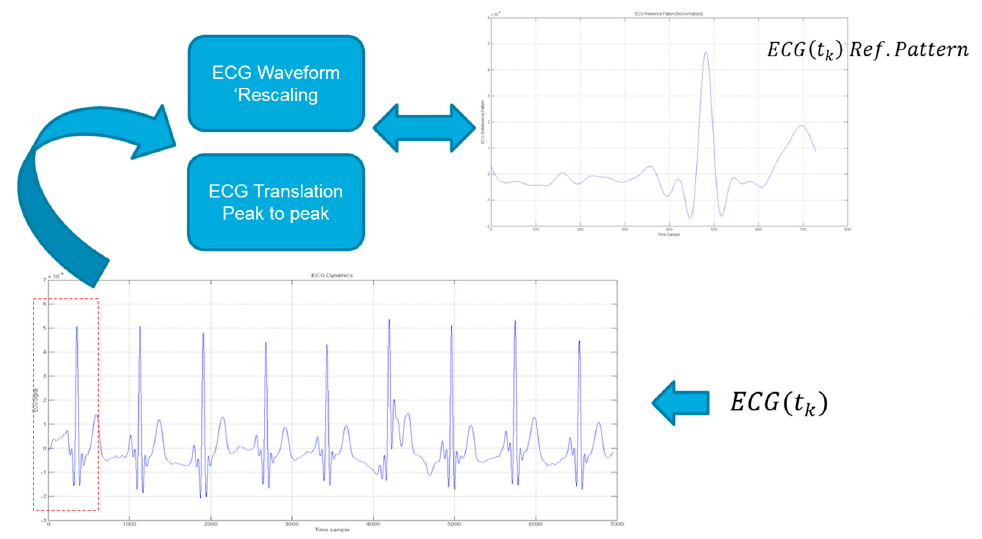
Figure 15. ECG(t k ) (bottom) to dPPG(t (cid:2921) ) dt⁄ (top) analysis.